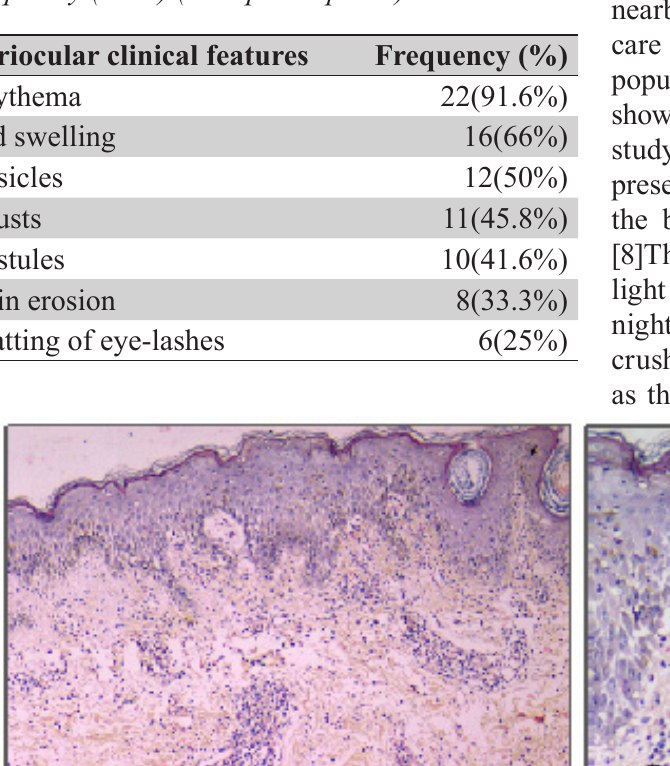
Figure 4: Clinical Images of Patients with Nairobi Eye, Showing Linear Erythematous Papulo- Vesicular Plaques. Table 1. Periocular Clinical Features and Their Frequency (n=24) (multiple response).